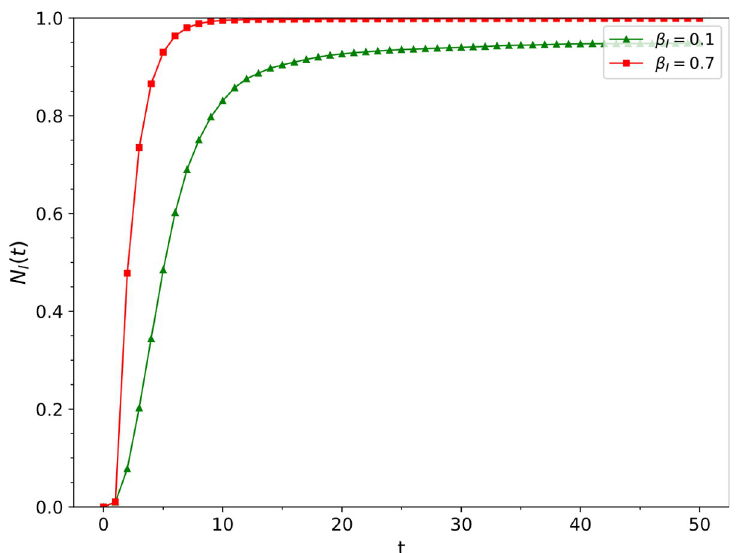
Fig 3. The influence of the information disseminatioin rate β I on ρ